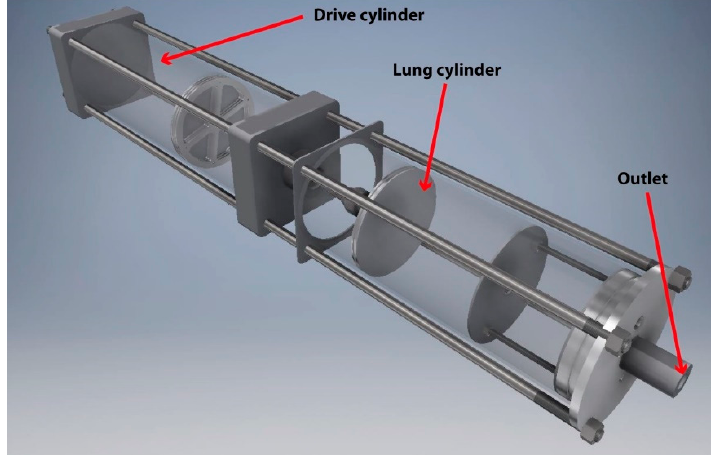
Figure 1. Design of the HSE cough simulator with the barrels transparent [15].